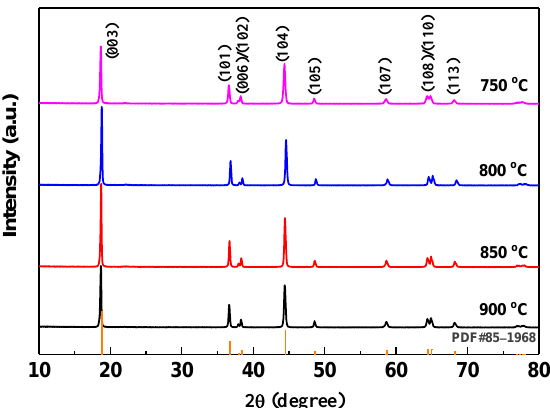
Figure 2. XRD patterns of LiNi 2/3 Co 1/6 Mn 1/6 O 2 prepared at different temperatures under O 2 atmos- phere. Table 1. Lattice parameters of LiNi 2/3 Co 1/6 Mn 1/6 O 2 materials prepared at different calcination tem- peratures.